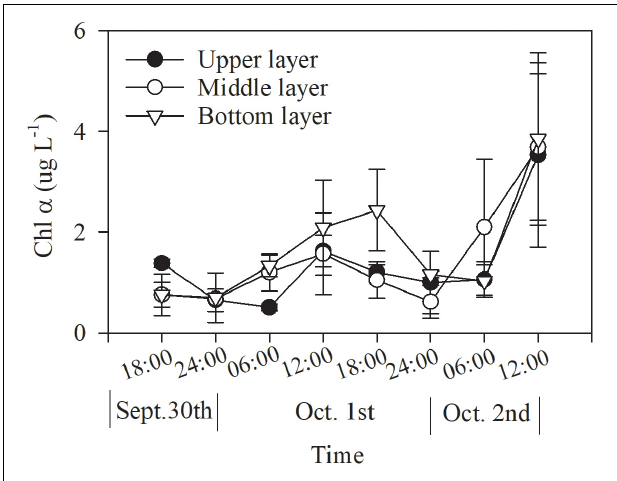
FIGURE 2 | Dial variation in Chl α concentration in Daya Bay during September 30 to October 2, 2014.